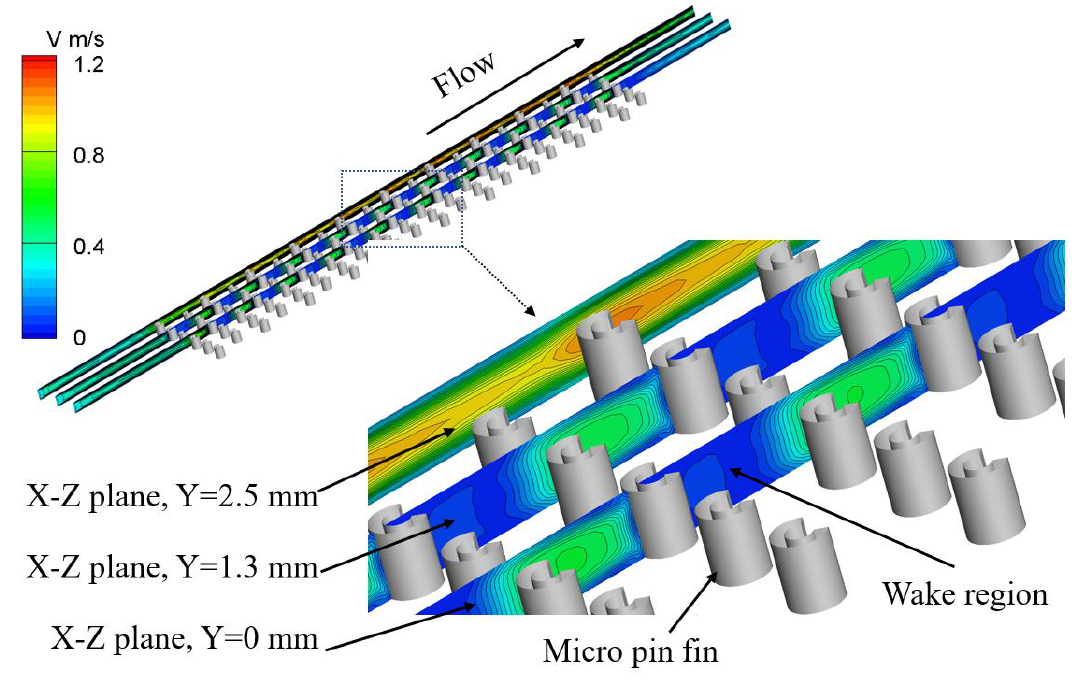
Figure 5. Velocity contour on parallel vertical planes in the staggered ring-shaped micro-pin-fin channel at Re = 200. The dimensionless average location of the vortex center in four types of micro-pin- fin arrays under different Reynolds numbers is shown in Figure 6. With the increase of Re , the vortices downstream the micro-pin-fins are stretched, and the vortex centers move downstream gradually, increasing the length of the wake region. Under the same Reyn- olds number, the distance from the rear stagnation point to the vortex center in the ring- shaped micro-pin-fin array is found to be greater than that in the circular array. At Reynolds numbers lower than 150, for either cross-section shape of pin-fin, the dimensionless location of vortex center exhibits little difference between the staggered arrangement and the in-line arrangement, indicating that the pin-fin s’ layout and spacing exert little influence on the vortex center location. At this low Reynolds number range, the size of vortex is relatively small, and the space is enough for the vortex to grow down- stream each pin-fin. Effects from other pin-fins are rather negligible. However, for a given layout, the cross-section shape of the micro-pin-fin has a notable influence on the vortex center location, which is larger in the ring-shaped micro-pin-fin array than that in the cir- cular array. This is because the existence of cavities behind the ring-shaped micro-pin-fins